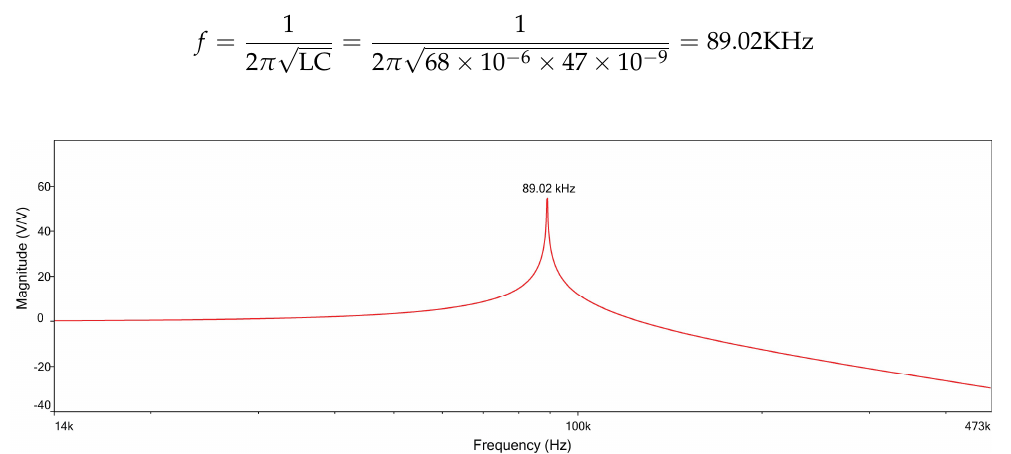
Figure 5. Magnitude vs frequency plot of the single-cell L.N. reported in Figure 3 showing the behavior of a low pass filter.